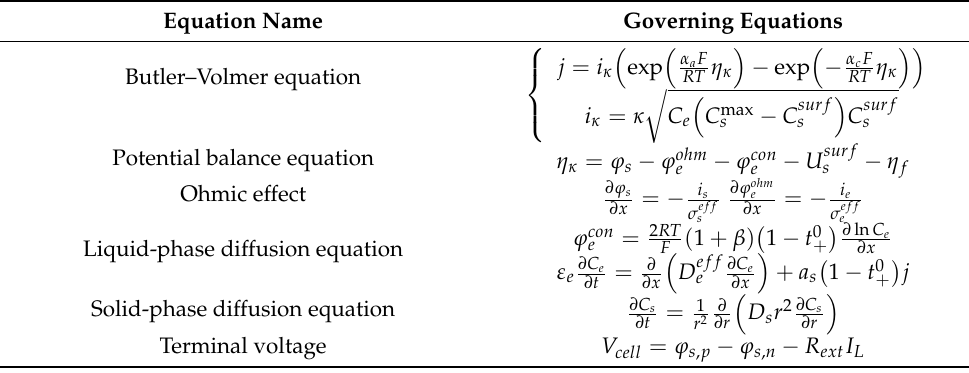
Figure 1. Physical model of P2D. Table 2. The original P2D model equation.